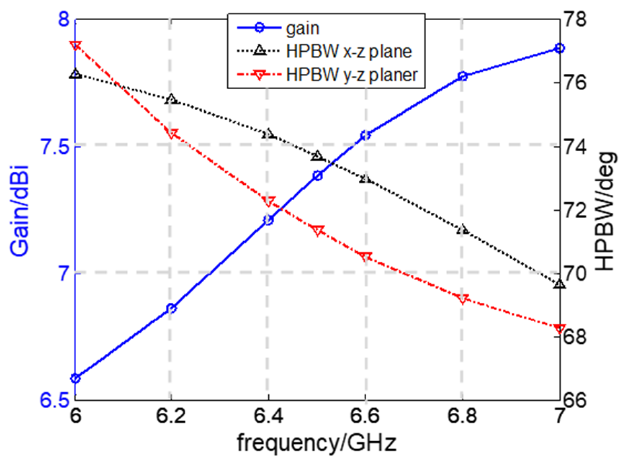
Figure 18. Simulated gain and half-power beamwidth (HPBW) of tag antenna against frequency.